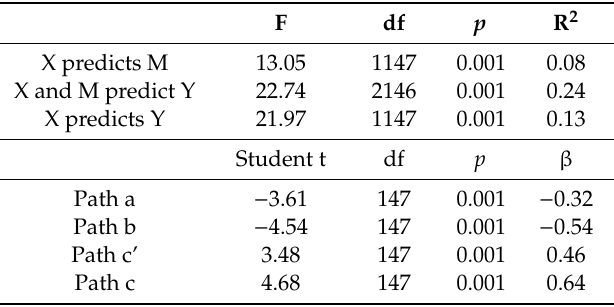
Table 4. Model 1 effect indices. In the table, the coefficients for all the effects of the mediation model number 1 are presented.